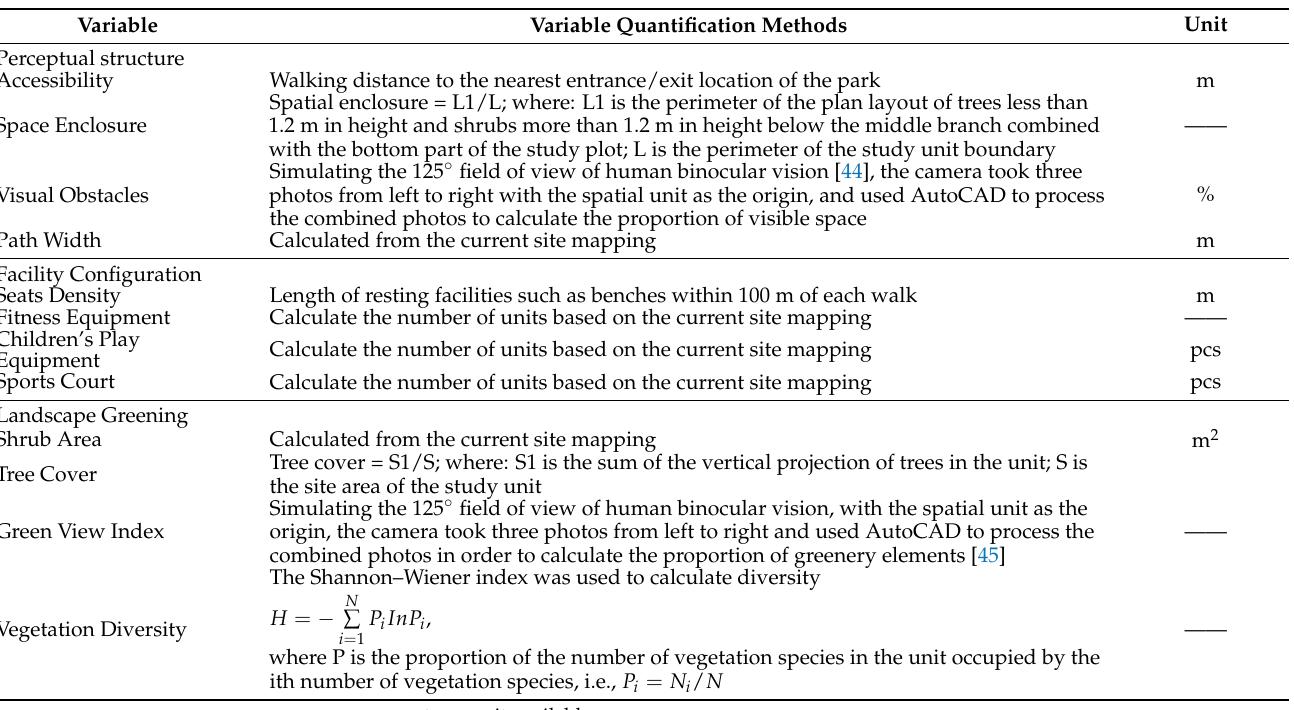
Table 4. Spatial variables that influence the community sports park’s interaction and their quantitative measurement